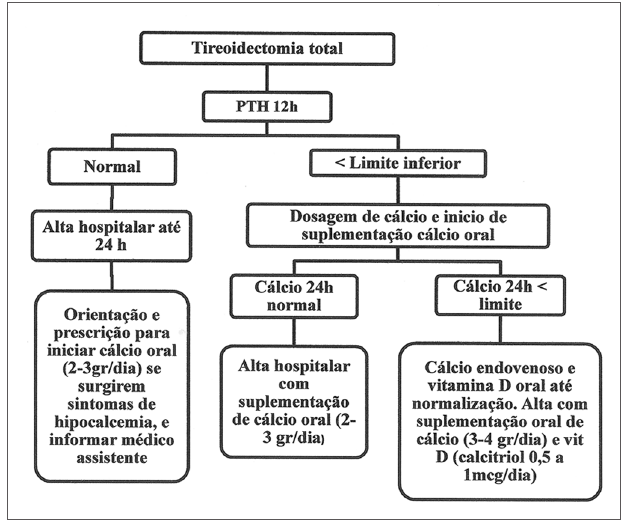
Figura 1. Algoritmo de dosagem única de PTHi 12h como preditor de hipocalcemia. PTH: paratormônio intacto.